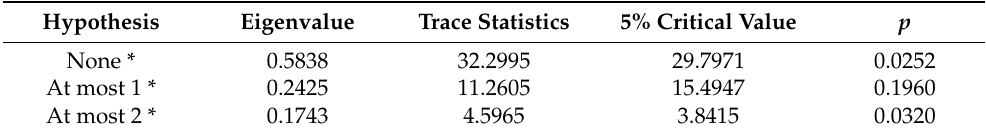
Table 8. Johansen cointegration test results.